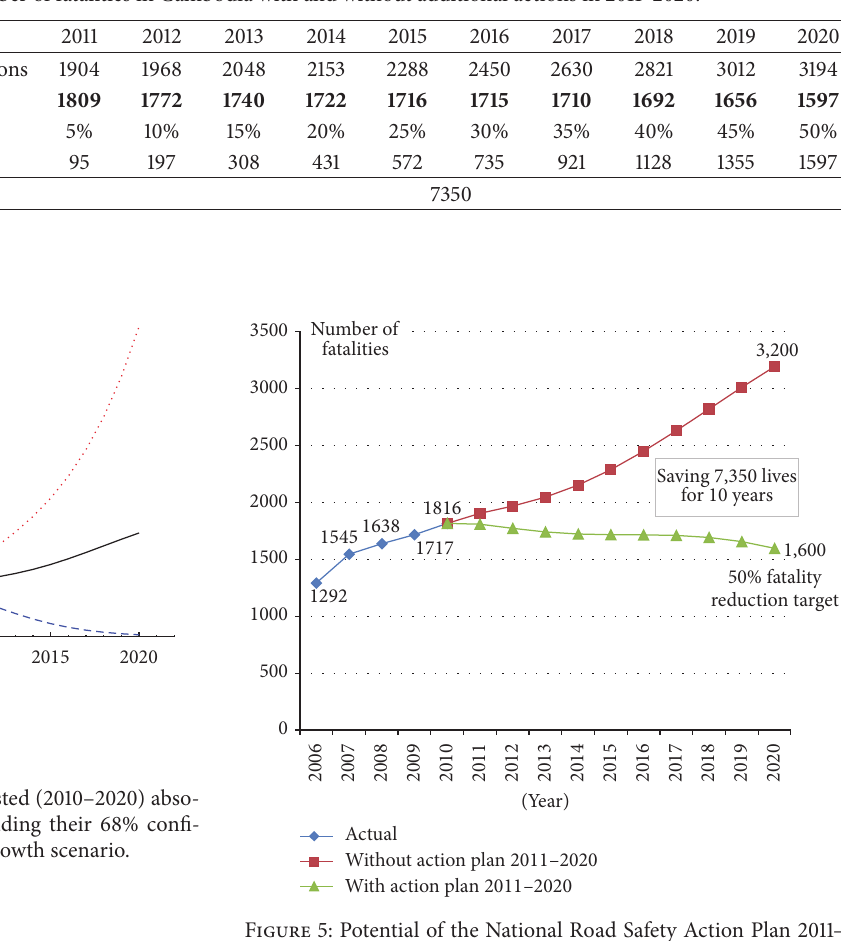
Figure 5: Potential of the National Road Safety Action Plan